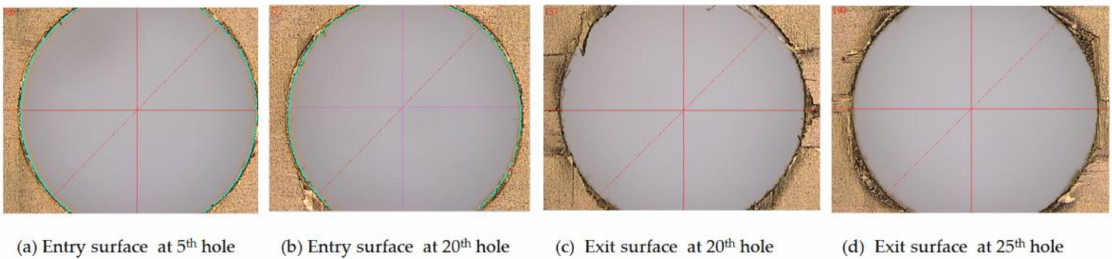
Figure 10. Typical surface morphologies of the drilled CRFP